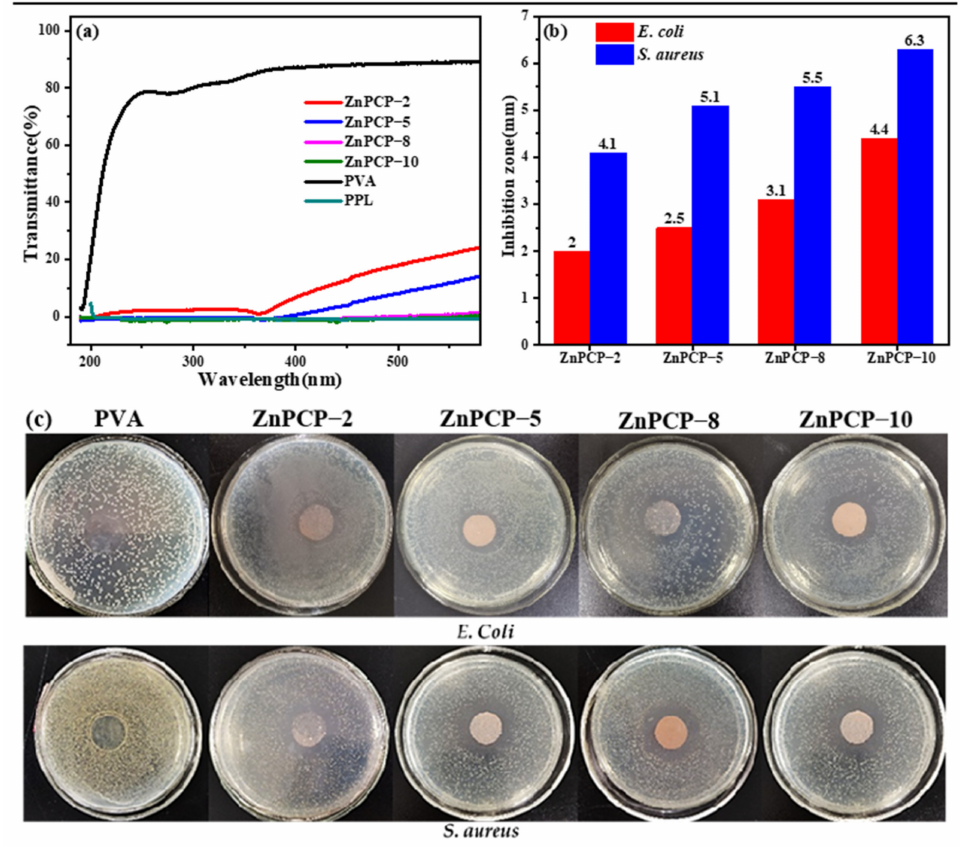
Figure 4. ( a ) UV transmittance of PVA, PPL and ZnPCP films with different mass fractions and ( b , c ) antibacterial effect of